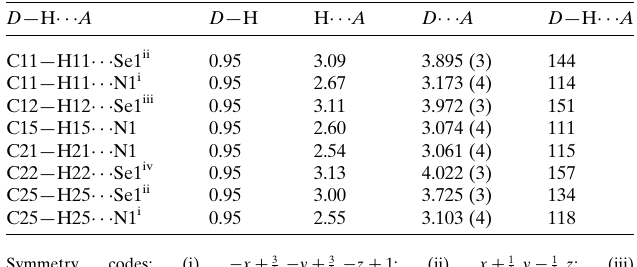
Table 2 Hydrogen-bond geometry (A˚ , (cid:4)